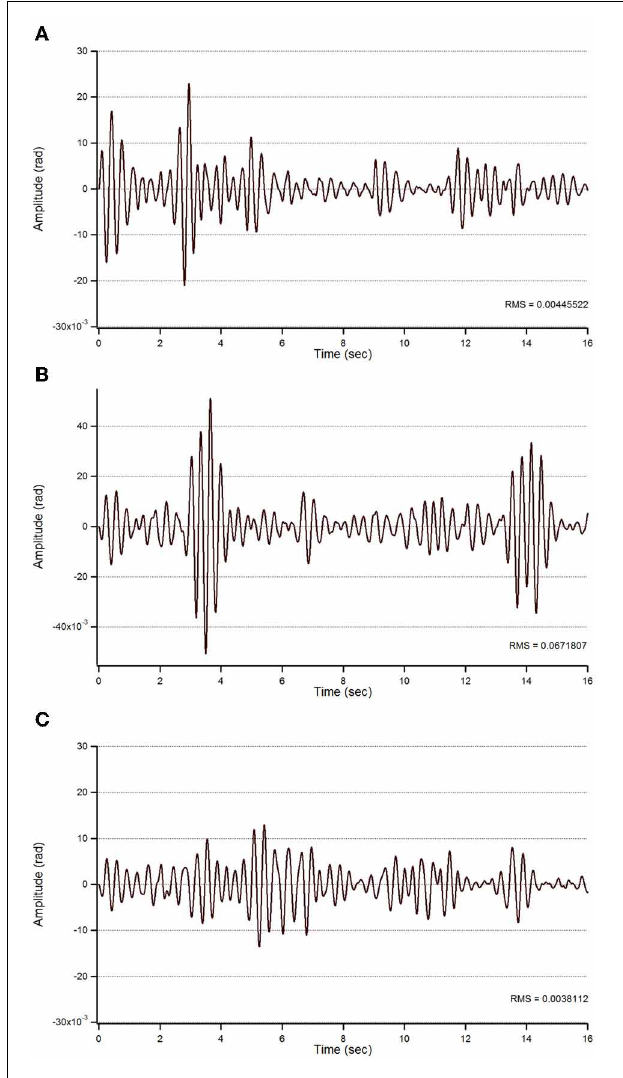
FIGURE 6 | STFT representation of action tremor in patient 2. (A) Baseline, (B) post-sham, (C) post-tCCDCS. See also legend of Figure 4